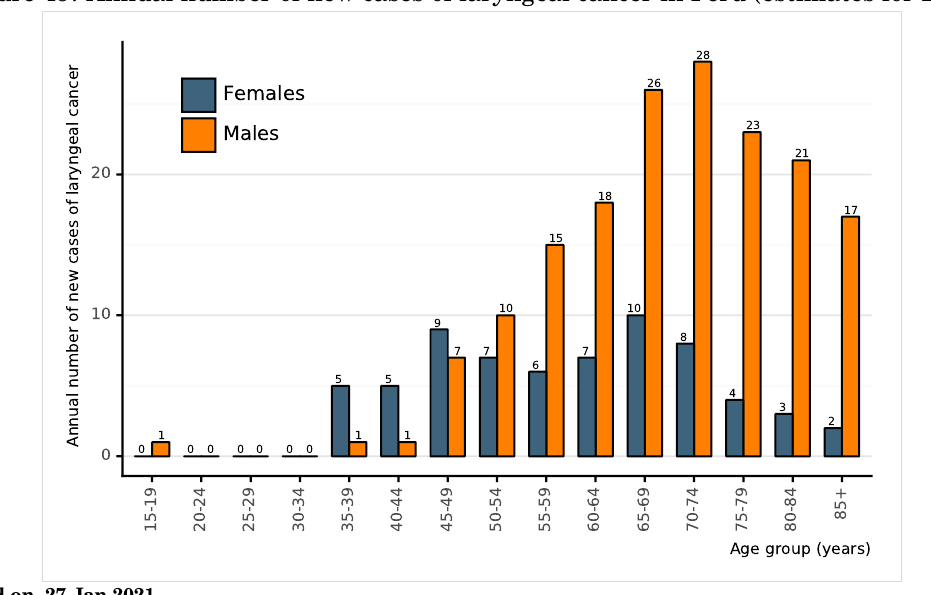
Figure 49: Annual number of new cases of laryngeal cancer in Peru (estimates for